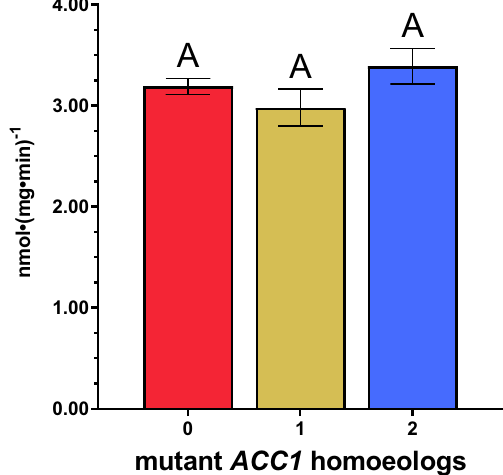
Figure 2. ACCase specific activity by genotype a,b . a Genotype refers to the number of homozygous mutations in ACC1 that result in a A2004V amino acid substitution, with up to three possible on group 2 chromosomes in hexaploid wheat (2n = 6x). These mutations result in quizalofop-resistant wheat ACCase. b Genotype specific activities labeled with the same capital letter are not significantly different according to Student’s t-tests (α = 0.05).